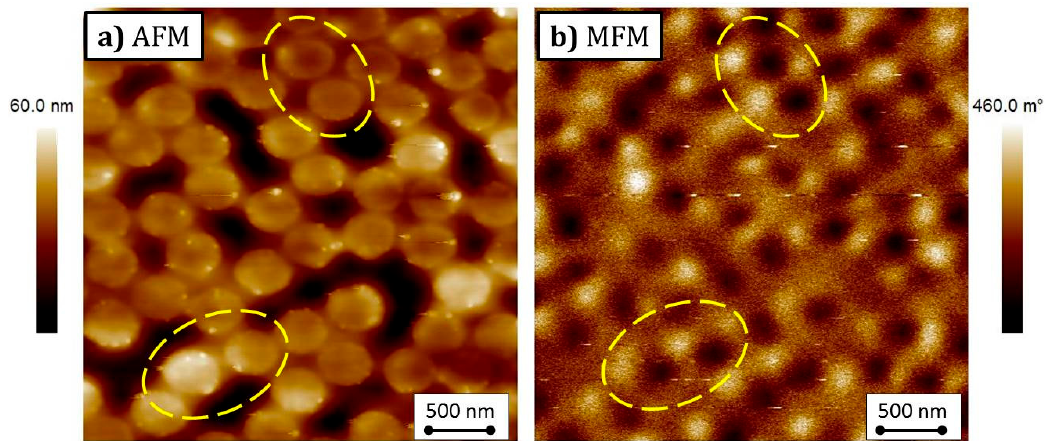
Figure 5. (Colour online) AFM image ( a ) and corresponding Magnetic force microscopy (MFM) image ( b ), taken at the magnetic remanence after saturation along the horizontal direction, of a portion of the bi-component nanostructured system. Highlighted areas put in evidence the Co dots whose magnetisation at zero applied field is close to the saturated state.